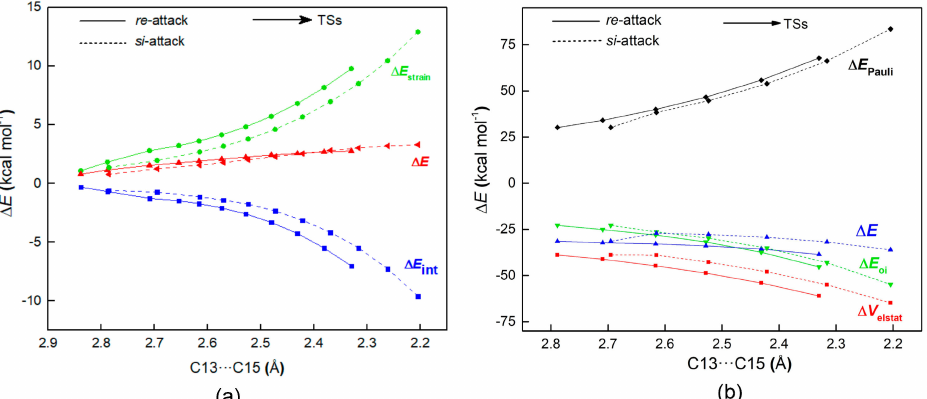
Figure 5. ( a ) ASM analysis of aza-Henry reaction between N -Boc ketimine (R1a) and nitromethane (R2) along the reaction coordinate projected onto the C13 · · · C15 distance for re - and si -pathways. ( b ) Evolution of ∆ E int of two energy components along the reaction